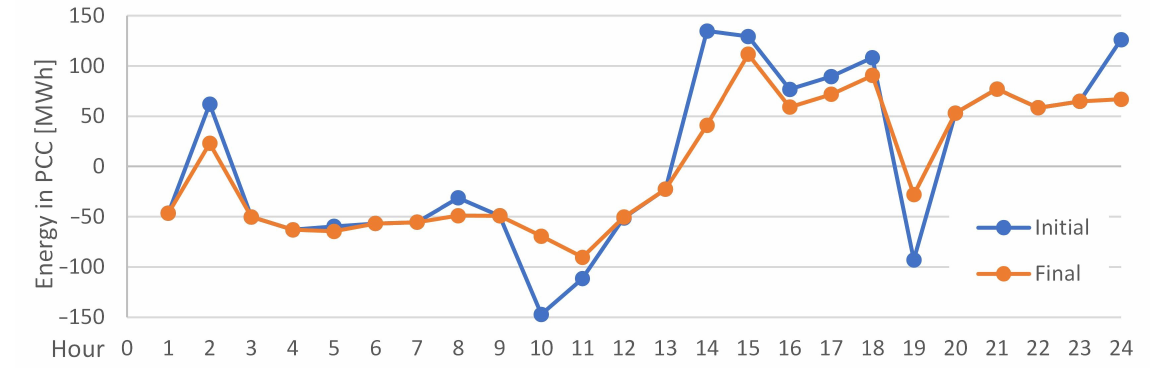
Figure 9. Energy transfered in PCC to DS 3.